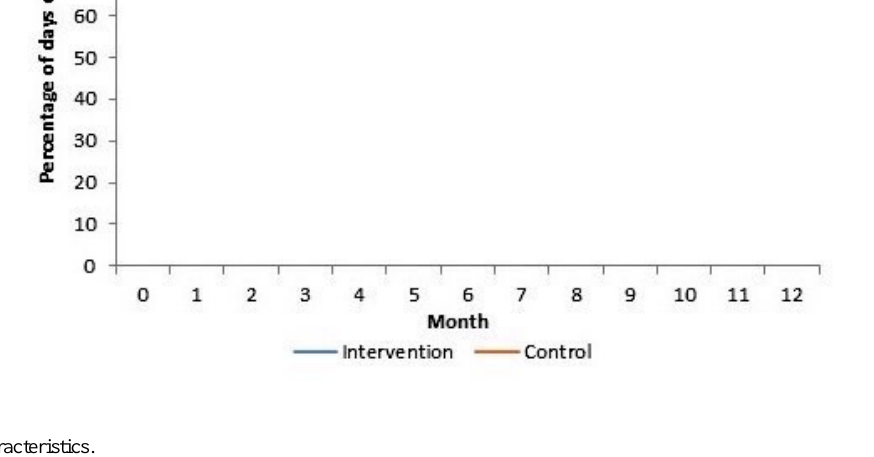
Table 1. Baseline characteristics.